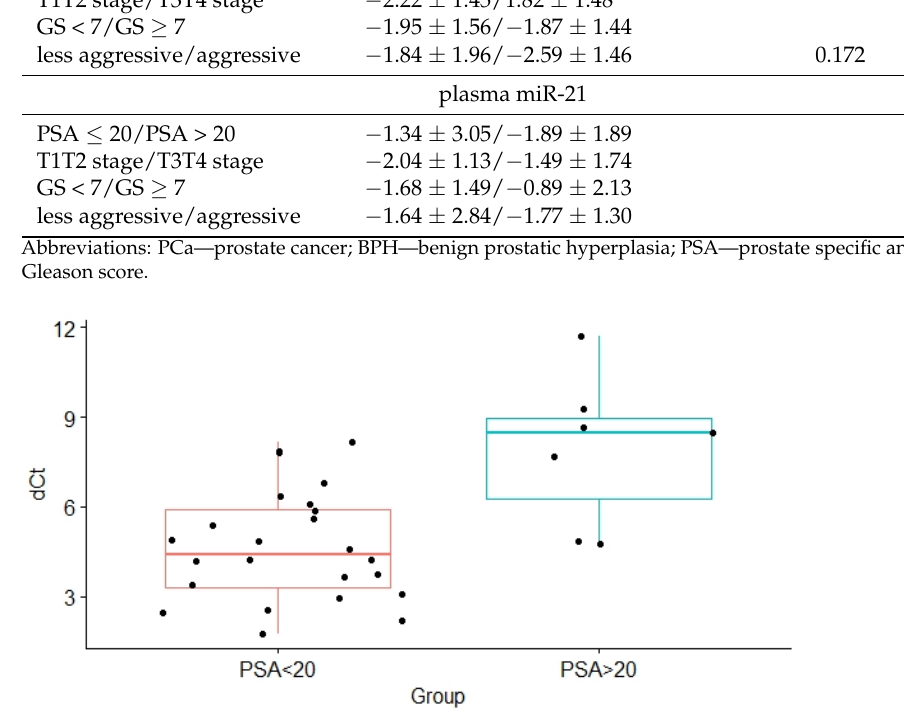
Figure 4. Difference in the expression levels of exosomal miR-21 between PCa patients with PSA values ≤ 20 and PCa patients with PSA values > 20. Relative miR-21 expression in subgroups was normalized against the spike-in and endogenous controls (dCt, y -axis). Data are shown as interquartile ranges with means ± SD. A Student’s t -test was used to determine statistical significance. dCt—delta cycle threshold; PSA—prostate specific antigen.